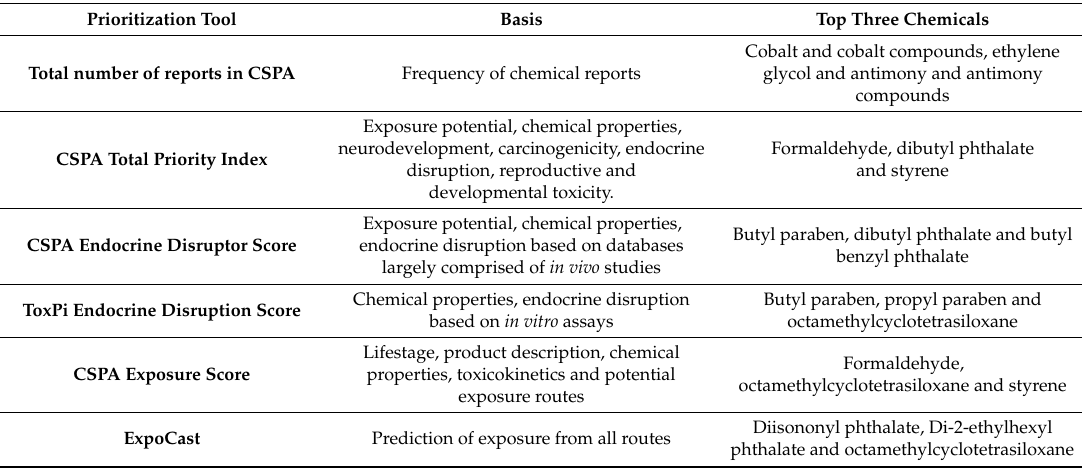
Table 5. Summary of prioritization tools, basis and the three highest scoring